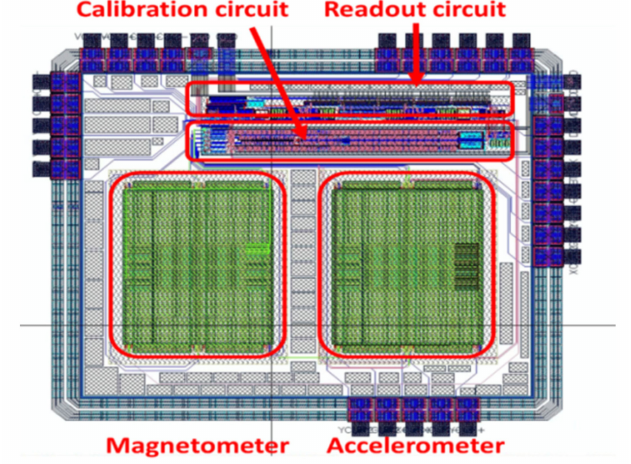
Figure 22. Layout view of the chip.